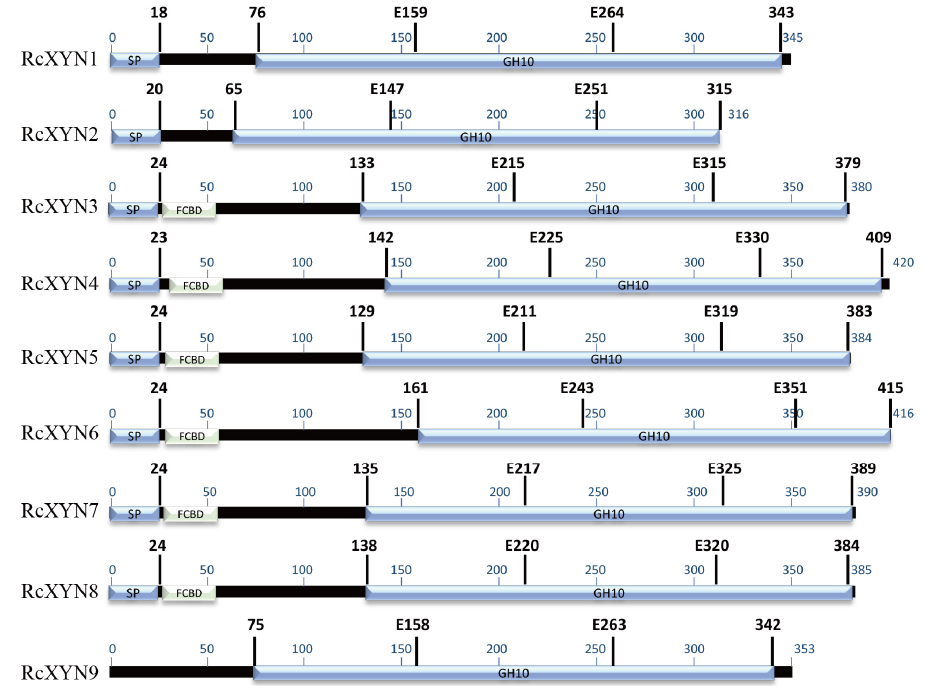
Figure 1. Predicted functional domains present in the GH10 family xylanases of R. cerealis . The region conserved in all the proteins is shown in blue. The glutamate responsible for catalysis is indicated by the letter E followed by a number that shows its position in the sequence. FCBD: fungal-type cellulose-binding domain.